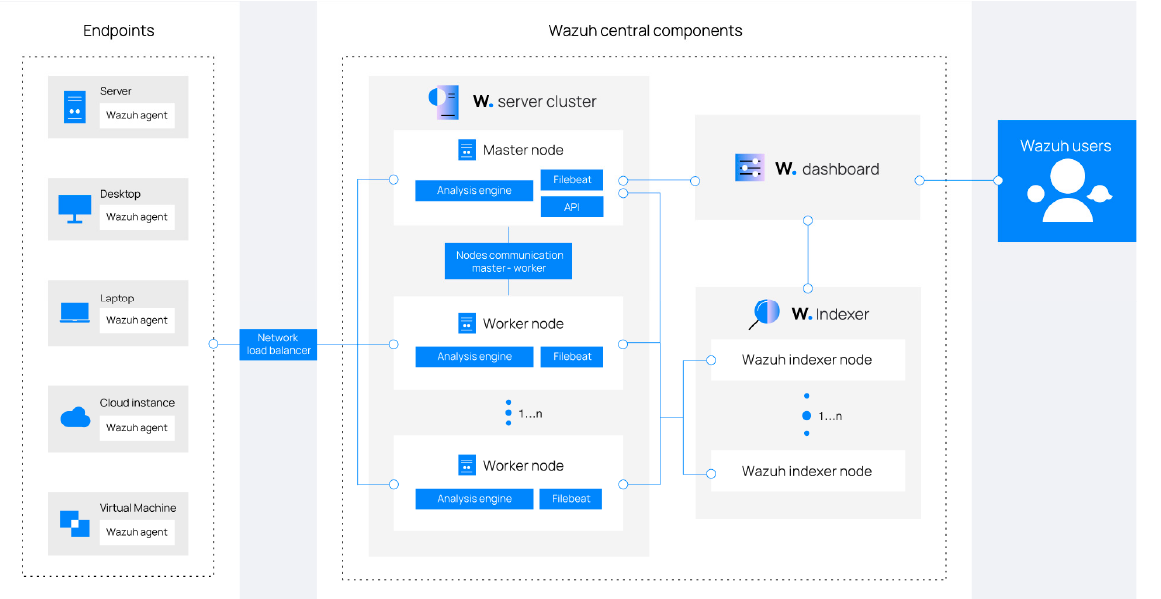
Figure 5. Wazuh Architecture Diagram [27] Reprinted/adapted with permission from Ref. [27]. Copyright 2023, Wazuh.